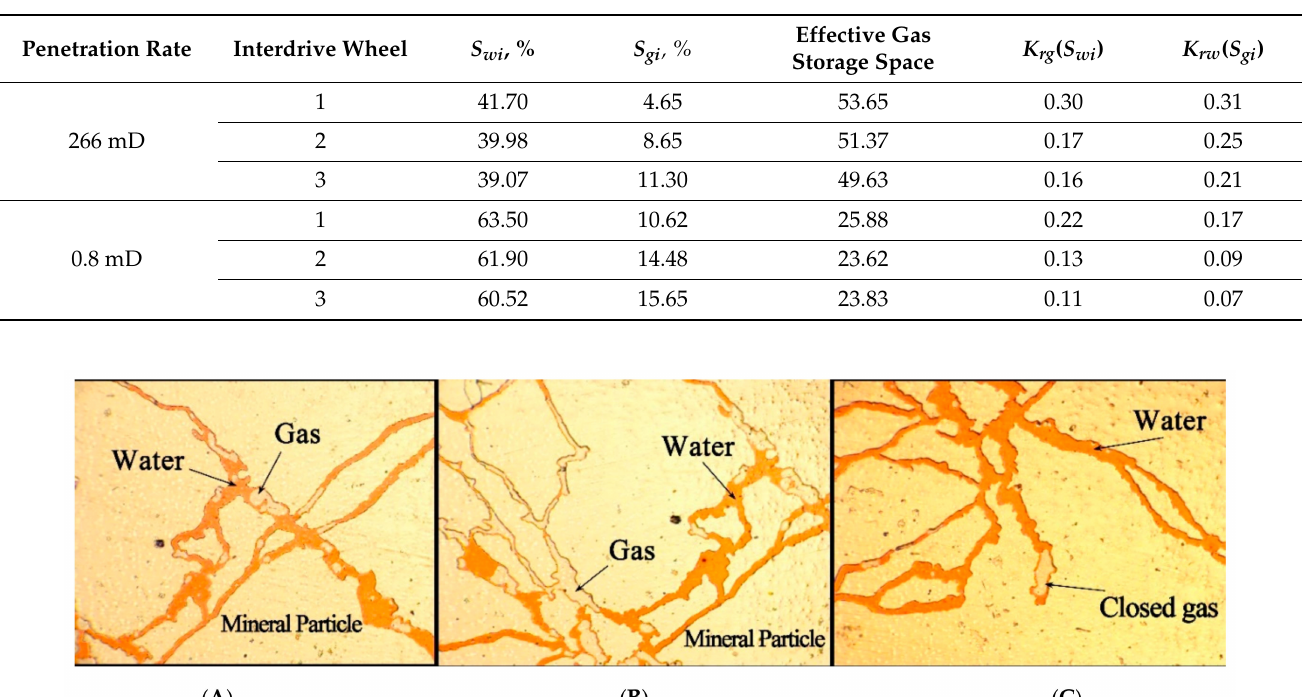
Table 4. Key parameter values of relative permeability under multiple rounds of mutual drive in cores with different permeability.